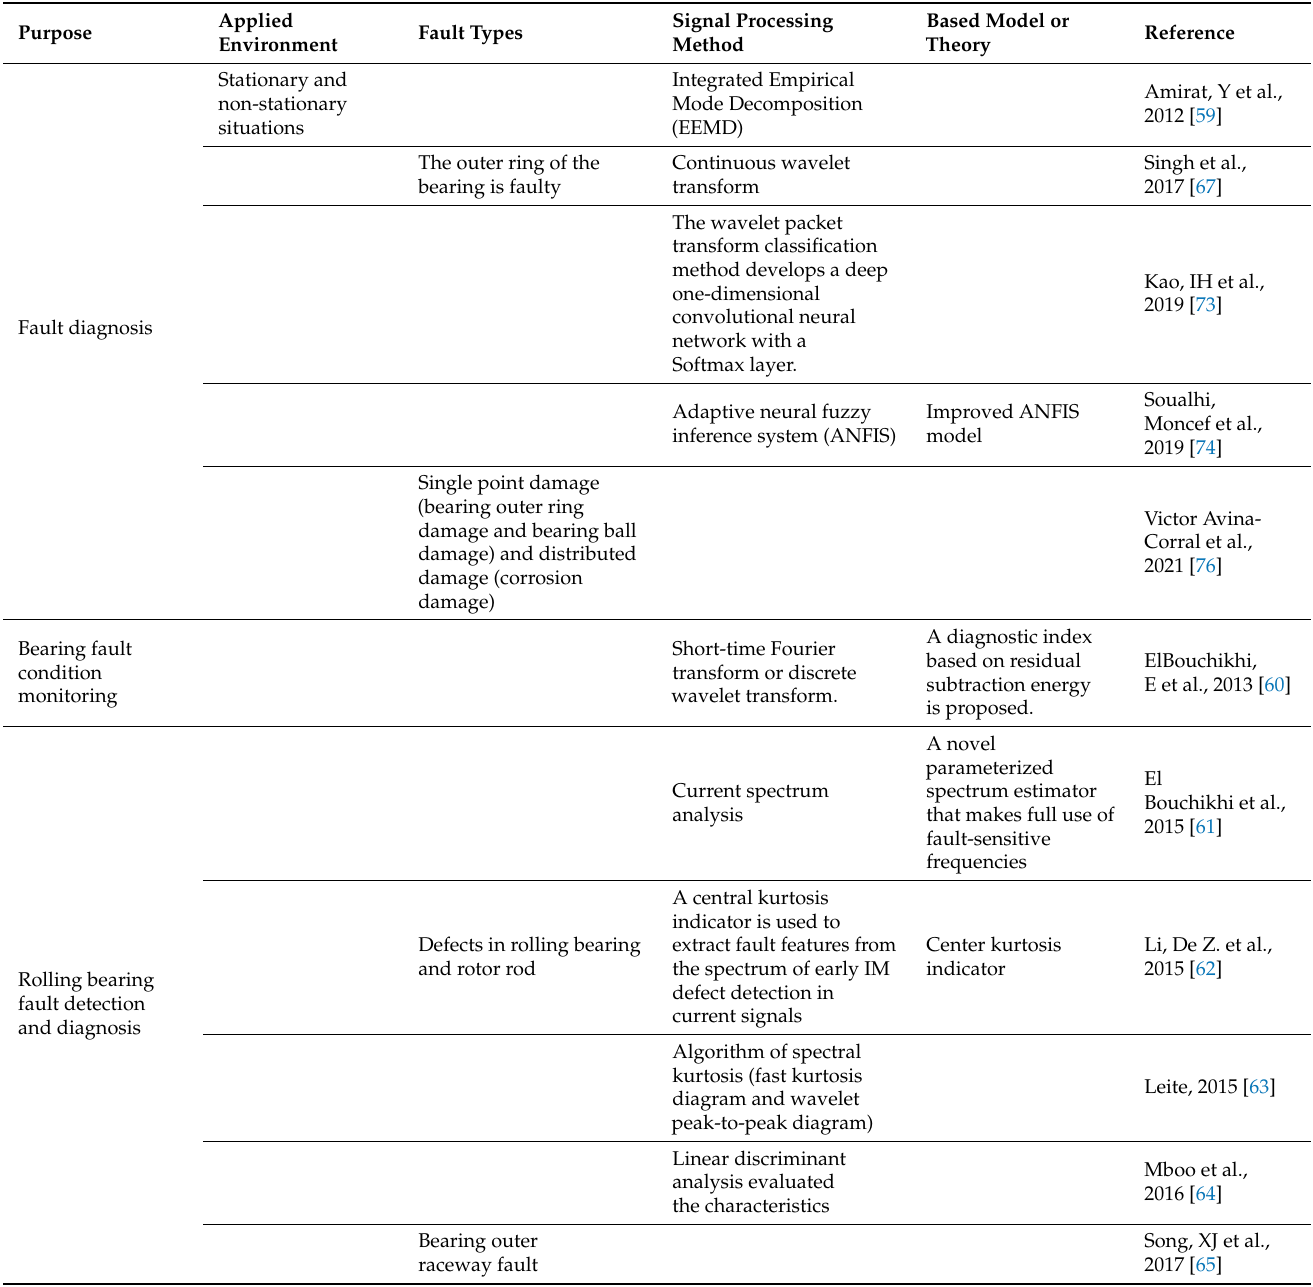
Table 5. Summary and comparison table of time-frequency signal analysis